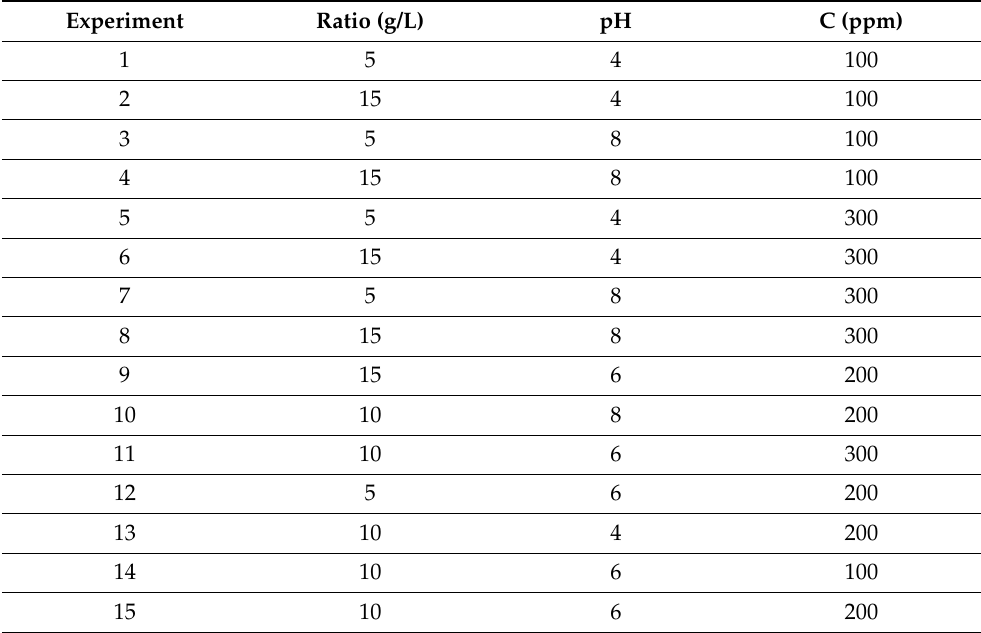
Table 1. Experimental conditions of the adsorption tests performed.